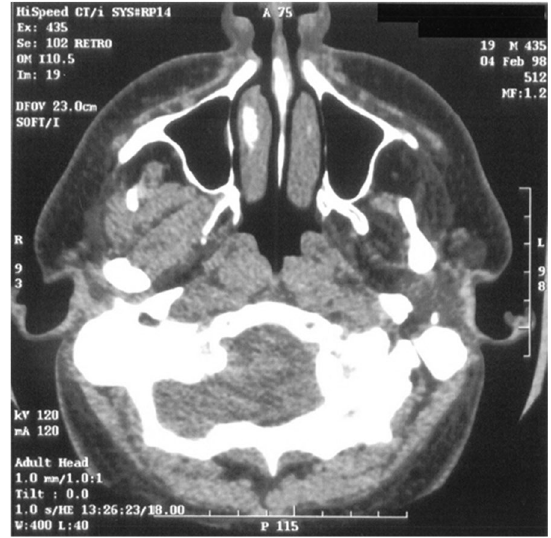
Fig. 2 CT scans. The severe atrophy with fat substitution of the left internal and external pterygoid, left masseter and left anterior temporalis muscles is